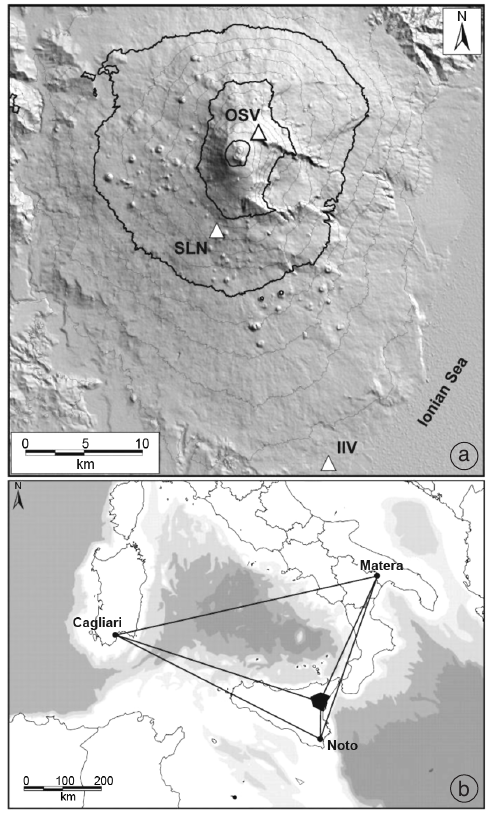
Fig. 1a,b. a) The Mt. Etna volcano and the Etnean GPS measurement sites are shown; b) the geographic location of the investigated area, in Southern Italy and the three ITRF stations taken into account during pro-